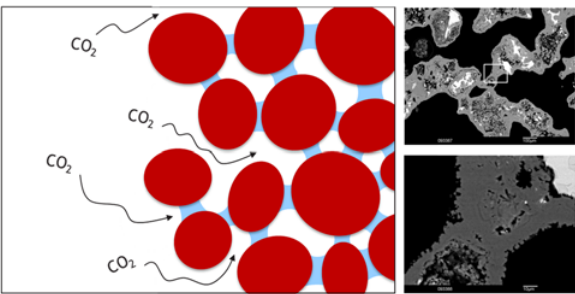
Figure 1. Moist carbonation of unsaturated compacts: schematic view (left), Backscattered electron microscopy images showing precipitation of calcium carbonates at pore necks and particle